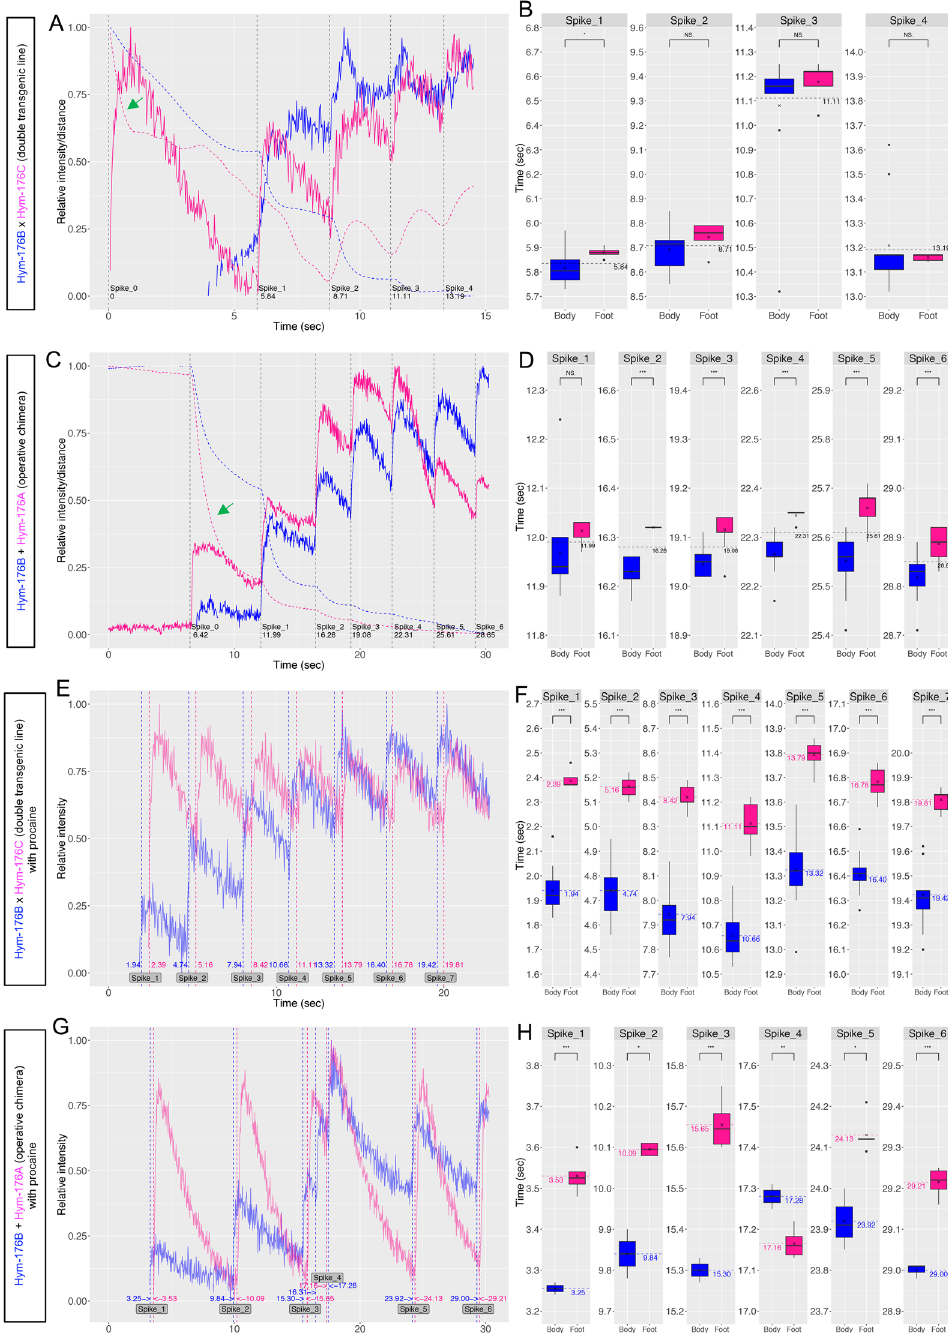
Figure 4. Coordinated interaction between body and foot neuronal circuit. Double transgenic line of Hym-176B::GCaMP and Hym-176C::GCaMP with ( E,F ) or without ( A,B ) procaine treatment. The operative chimera of Hym-176B::GCaMP and Hym-176A::GCaMP with ( G,H ) or without ( C,D ) procaine treatment. Normalized neuronal activity of representative neurons from body circuit in blue and foot circuit in red; cell #1 and #16 in Fig. 3B ( A ), cell #15 and #89 in Fig. 3D ( C ), cell #5 and #83 in Fig. 3F ( E ), cell #2 and #9 in Fig. 3H ( G ). Vertical dashed black/blue/red lines are as described in Fig. 3. Normalized distance between the three designated neurons in each animal was calculated for cell #9, #14 and #16 in Fig. 3B ( A ), and cell #7, #21 and #87 in Fig. 3D ( C ). Normalized distance between the first two neurons, shown by the dashed blue line, and between the last two neurons, shown by the dashed red line, indicates body and foot length, respectively. Box plot of the spike timing of all tested neurons in the body (blue) and foot (red) circuit for each spike ( B,D,F,H ). The horizontal dashed black line in ( B,D ) indicates the average spike timing of all tested neurons in both circuits, corresponding to the vertical dashed black line in ( A,C ), respectively. The horizontal dashed blue/red line in F and H indicates the average spike timing of all tested neurons in the body/foot circuit, corresponding to the vertical dashed blue/red line in ( E,G ), respectively. Statistical significance of the difference between average spike timings of body and foot circuit was evaluated by two-sided Student’s t-test; NS: no significant difference; *p < 0.05; **p < 0.01; ***p <